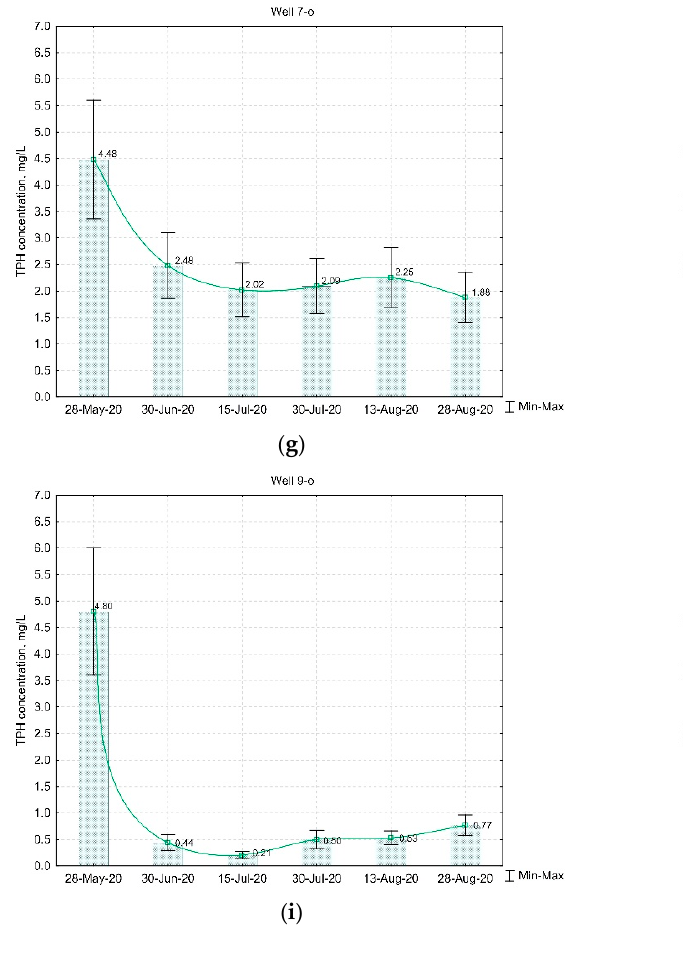
Table 2. Groundwater parameters at final stage of treatment system testing (28 August).